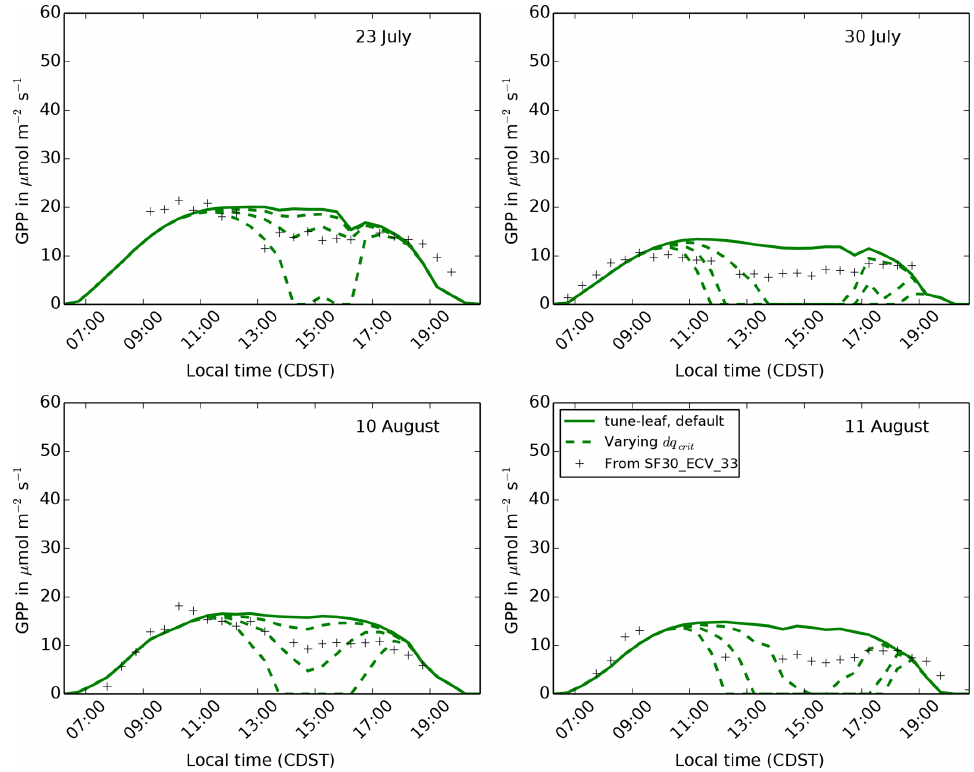
Figure 14. The diurnal cycle of GPP at site 4439 in the FIFE area for 4 days in during the dry period of 1987. Solid green lines use the tune-leaf configuration. Dashed dashed green lines show how GPP varies if dq crit is increased, while f 0 is changed to maintain the best fit to the Konza Prairie C 4 grass observations in Lin et al. (2015) (upper, middle and lower dashed lines correspond to parameter combinations a, b and c, respectively, as defined in Table